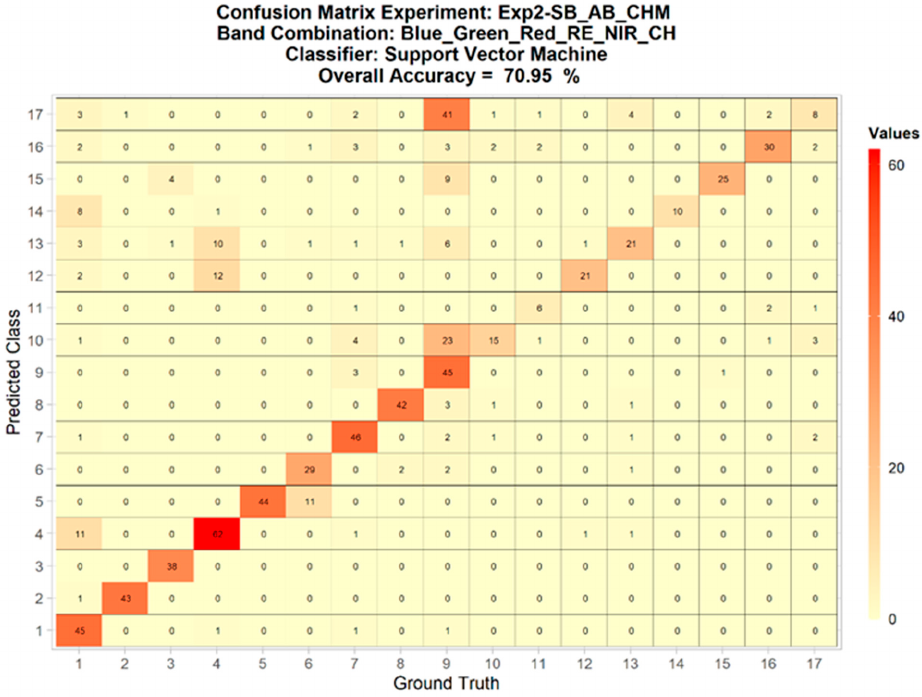
Figure A15. Confusion matrix for the best results obtained in Exp2-SB_AB_CHM, using the Support Vector Machine classifier (the Blue_Green_Red_RE_NIR_CH band combination).